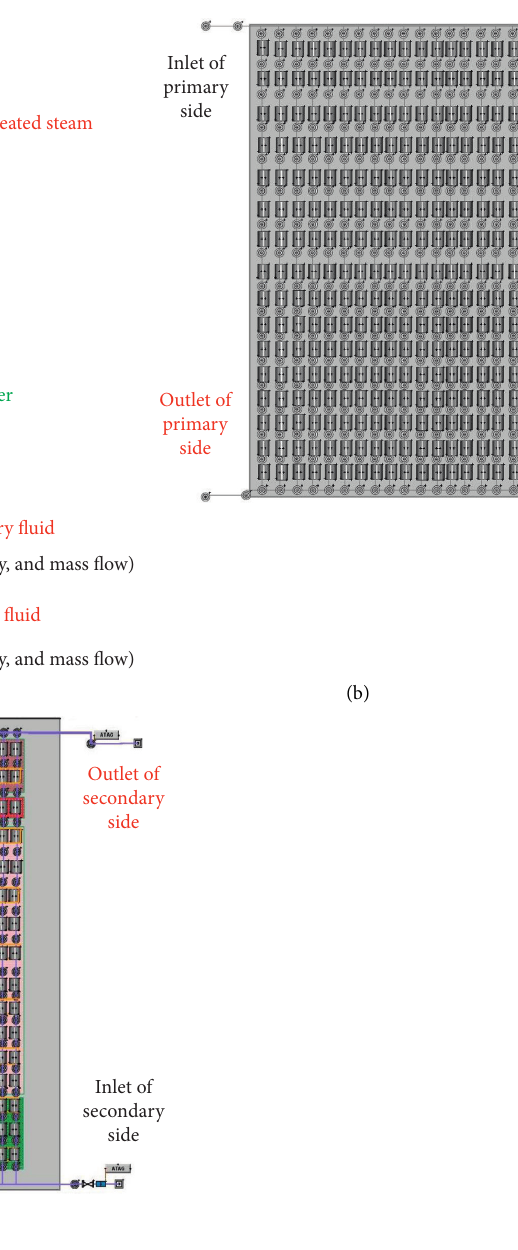
Figure 5: The matrix model of SG in vPower code: (a) the typical bundle and its model of vPower code; (b) SG model of the primary side; (c) SG model of the secondary